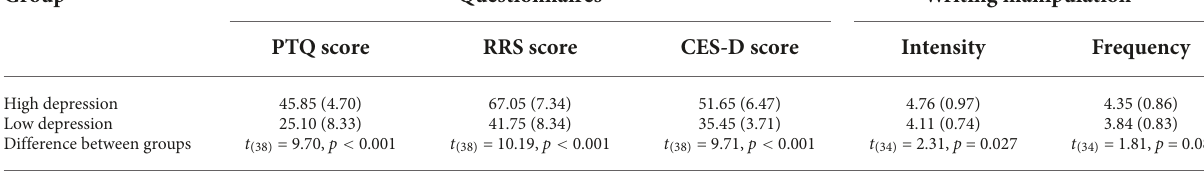
TABLE 1 The average and standard deviation (in brackets) of the scores across the high and low depression groups.